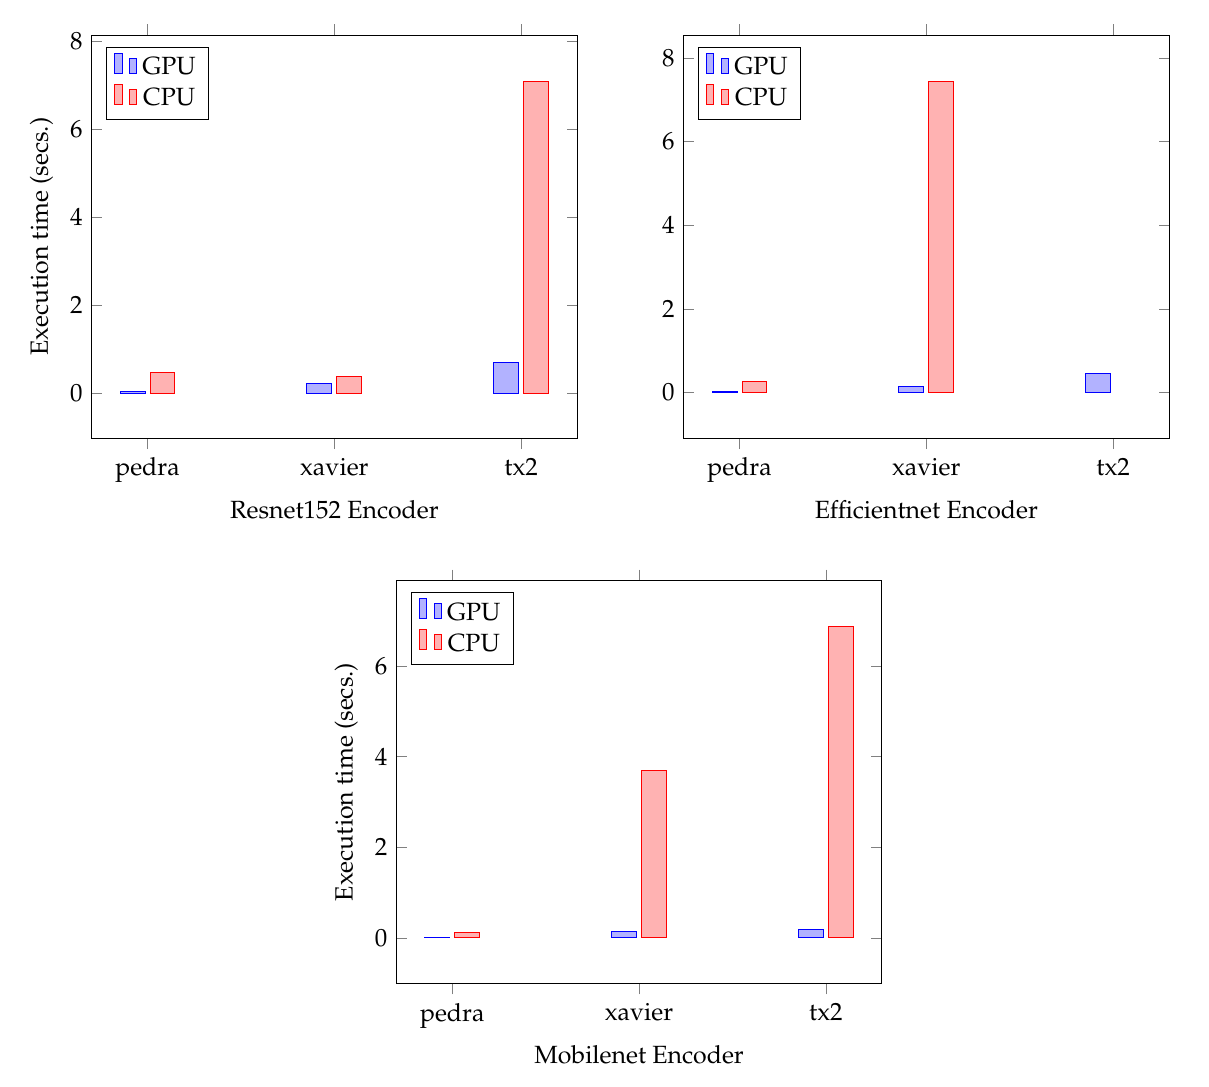
Figure 13. DeeplabV3 architecture inference time comparative with all